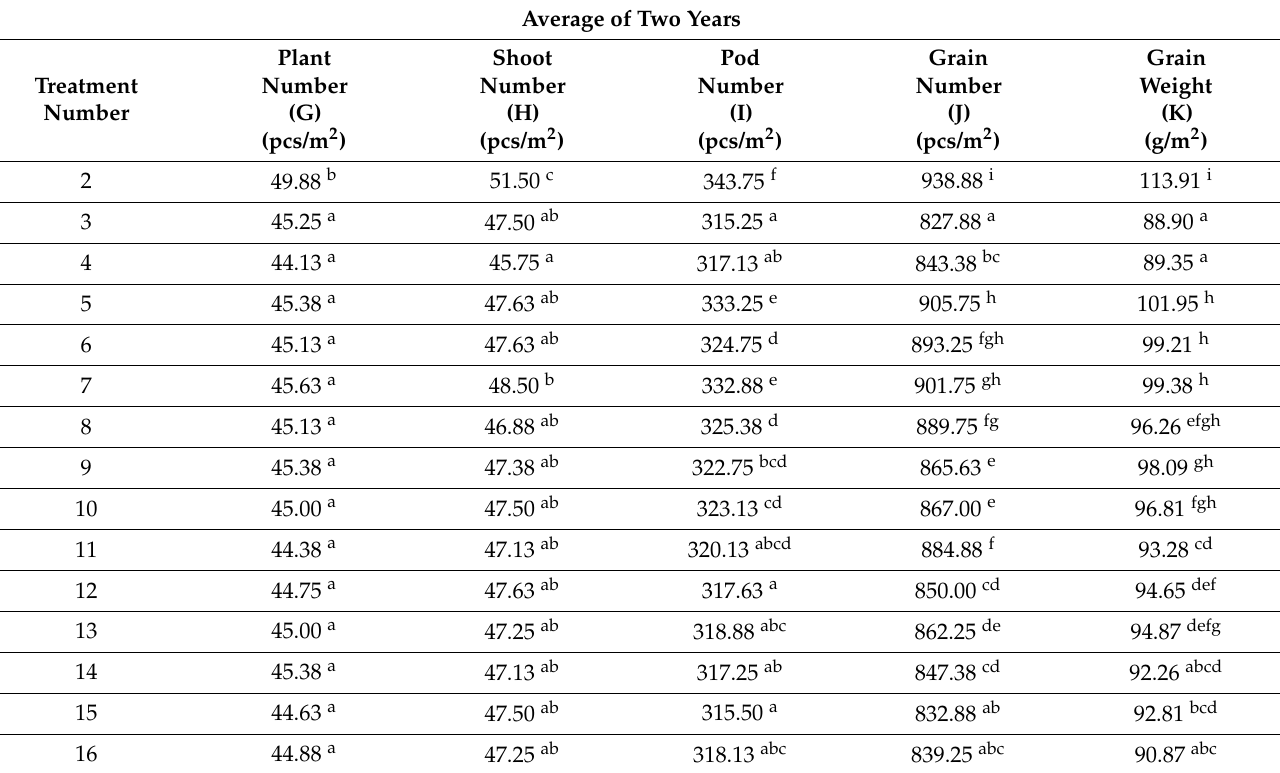
Table 13. Changesinwinterpea( Pisumsativum